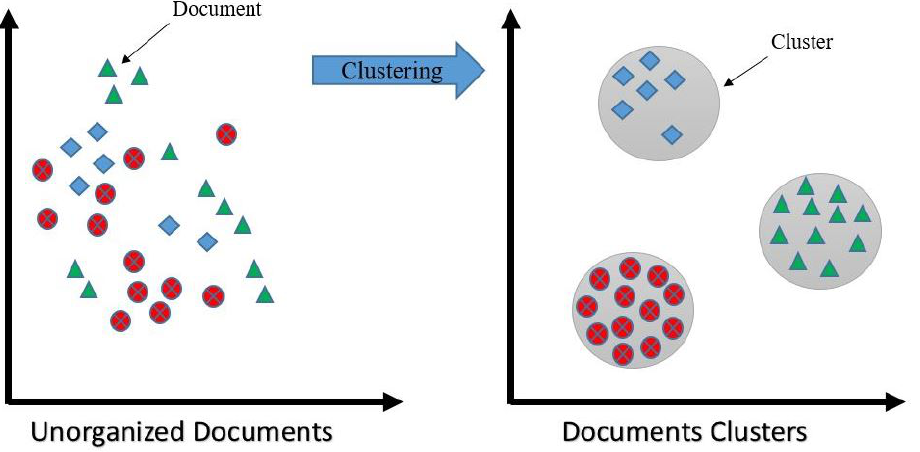
Figure 1. A simple example of the clustering